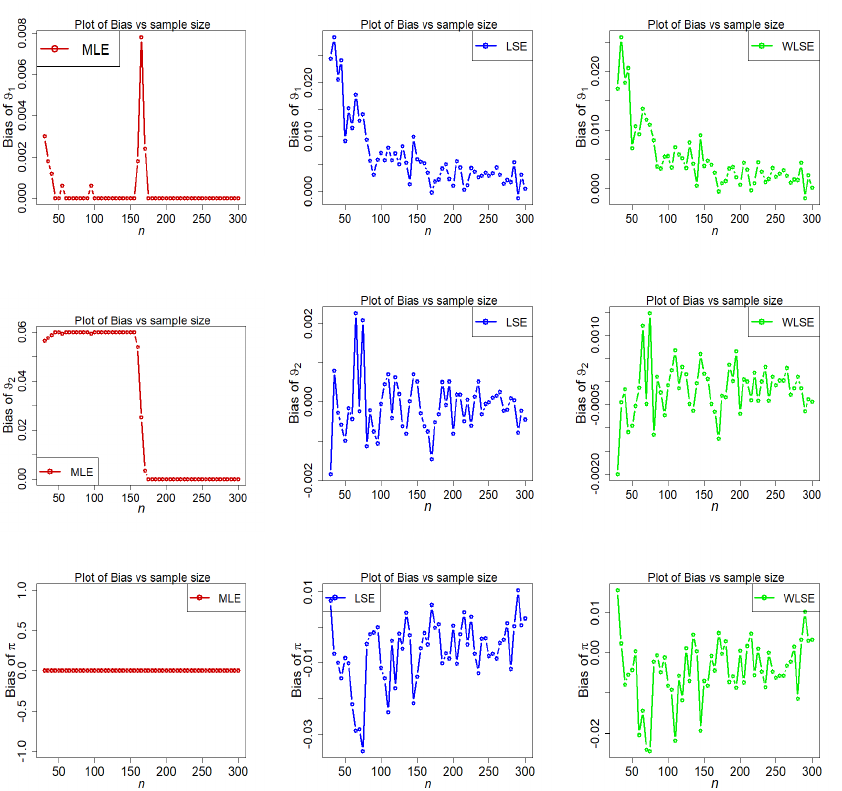
Figure 11. Fluctuations of bias of estimators under different methods for parametric set III.